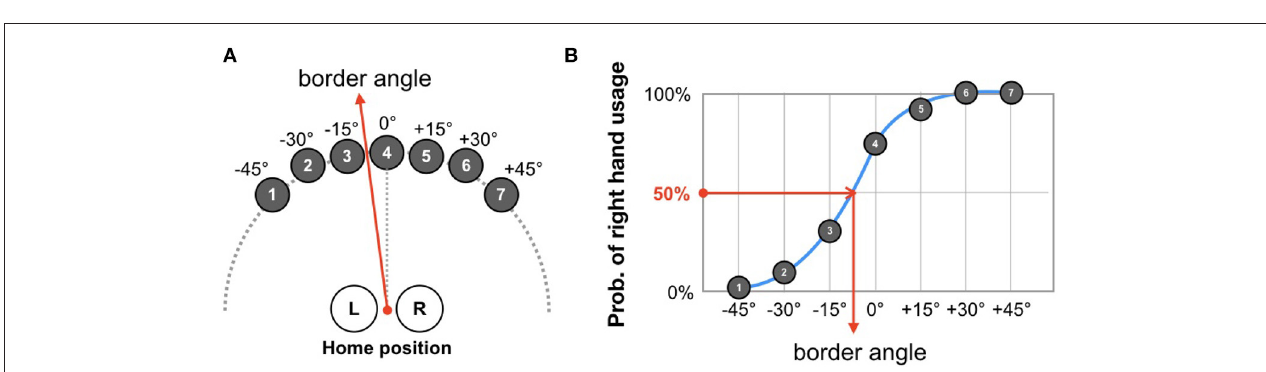
FIGURE 2 | Definition of border angle. (A) At each trial, participants were asked to reach toward a target that was randomly drawn from seven candidate positions. The task was repeated until 70 trials were completed (10 times for each target). (B) According to the probability distribution of right-hand usage, the border angle is determined as the angle-approximated psychometric function that results in a probability of 50%.